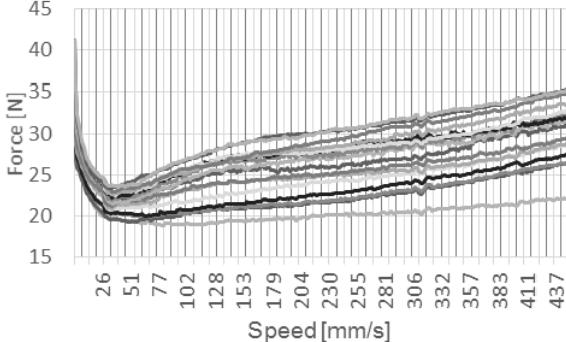
Fig. 8. The results of measuring the friction force as a function of speed for a pressure from 0.1 to 1.5 Bar . Lower line is lower pressure.